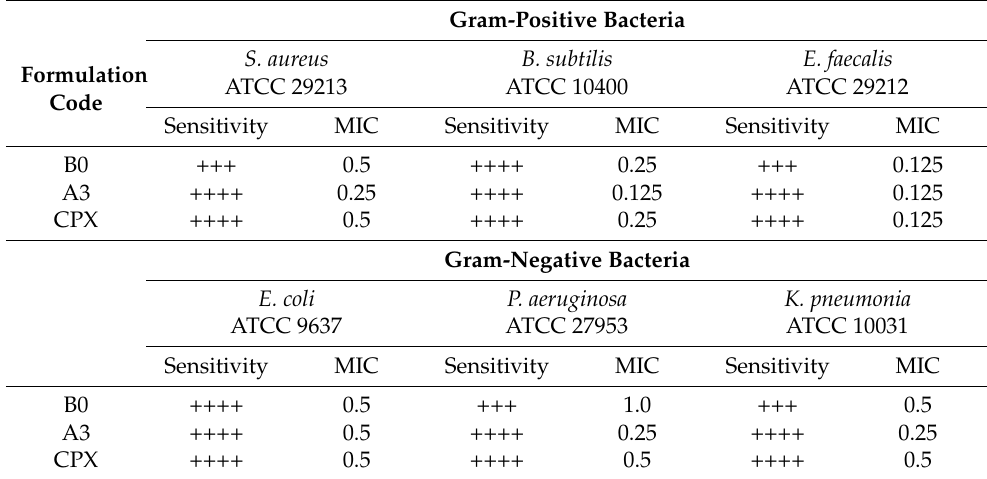
Table 1. Antibacterial activity of selected ophthalmic ciprofloxacin (CPX) colloidal lipid-based formulations (CPX-CLBFs) and the commercial one. Gram-Positive